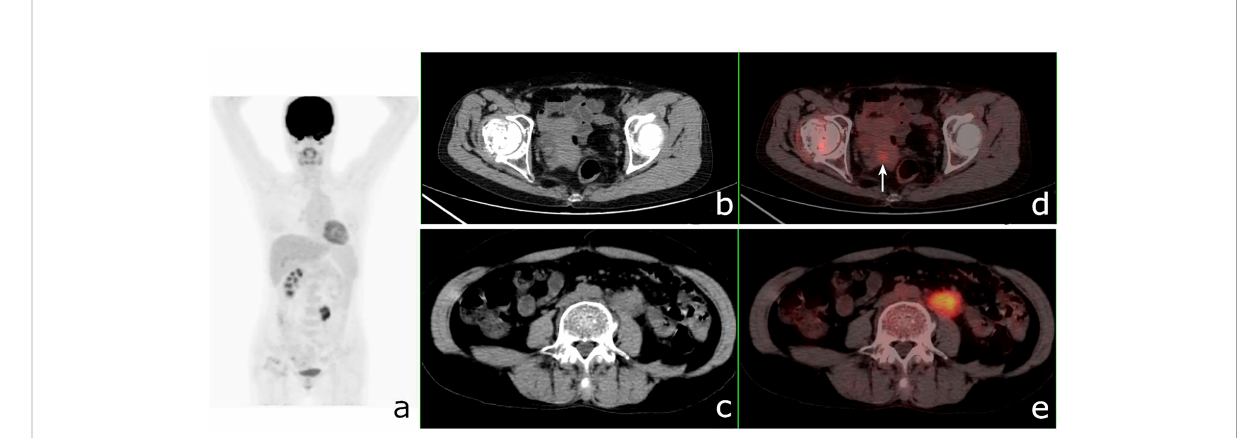
FIGURE 9 18 F- fl uorodeoxyglucose positron emission tomography/computed tomography ( 18 F-FDG PET/CT) of a 49-year-old woman with ureteral squamous cell carcinoma and endometrial carcinoma. PET/CT revealed a 41 × 20-mm mass in the left ureter with a maximum standardized uptake value (SUV max ) of 7.7 and a nodular hypermetabolic lesion (SUV max = 2.7) ( arrow ) misinterpreted as physiological FDG uptake in the uterine. (A) PET/MIP. (B, C) Axial CT. (C, D) Fusion